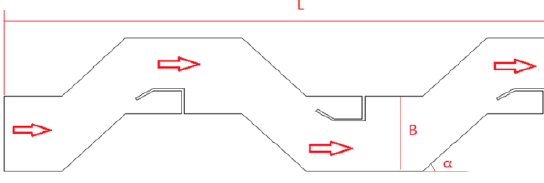
Figure 2. Single channel structure of the air–water separator.